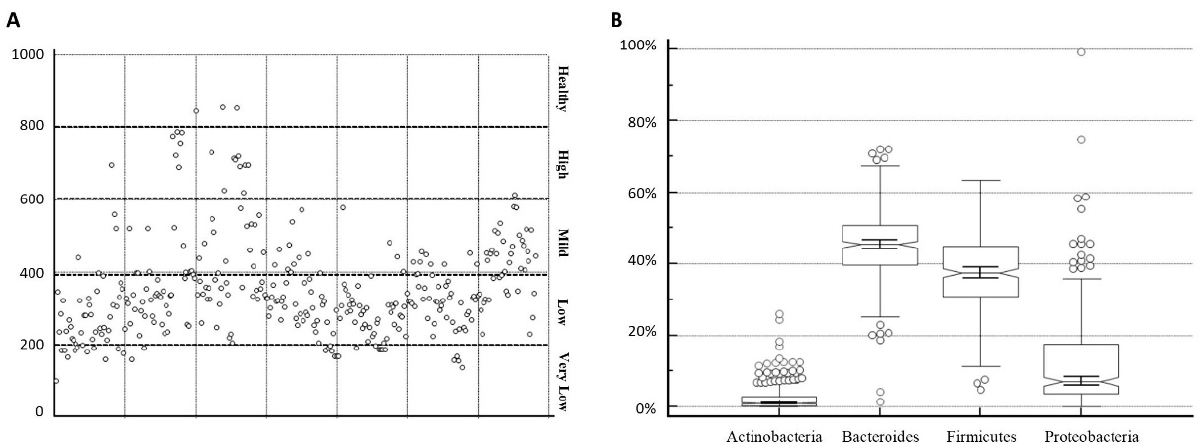
Figure 1. Panel ( A ) Levels of biodiversity in the population tested, divided by the index established. Panel ( B ) Whisky box representation of the spp percentages detected. Table 2. Median values of the percentages of the spp detected compared with the health reference values.